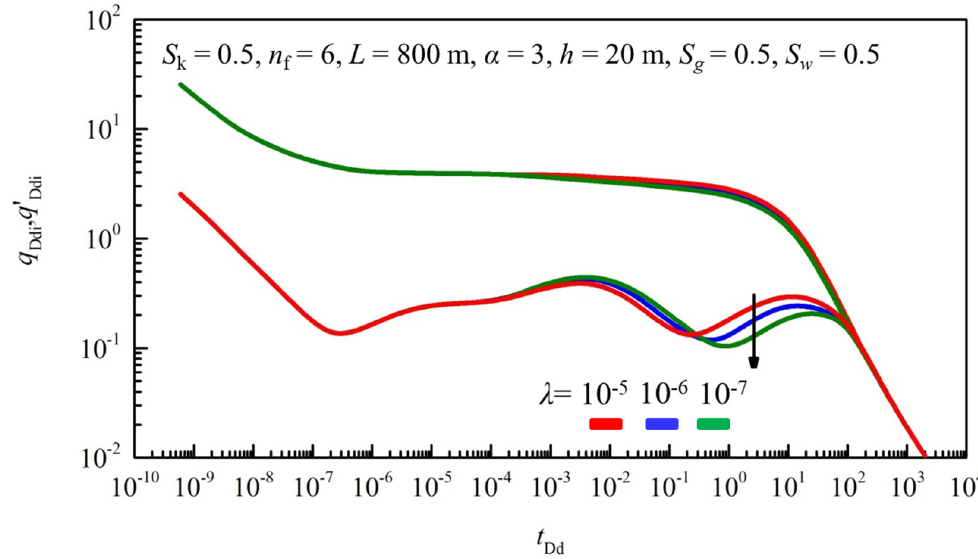
Figure 6. Effect of interporosity flow coefficient on dimensionless production integrals and deriva- tive curve.